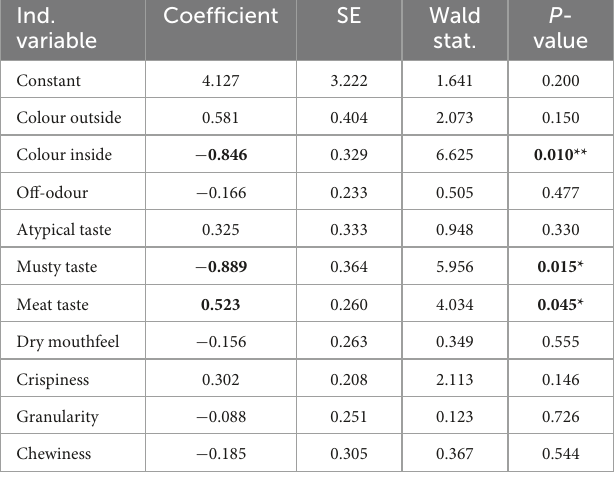
TABLE 4 Multiple logistic regression analysis of